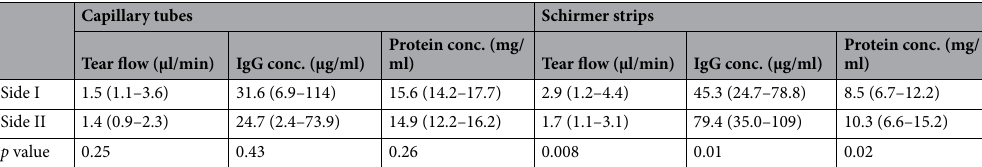
Table 2. Flow rate, total protein and IgG concentration. Tear fluid samples were collected with capillary tubes and Schirmer strips first from one eye (side I) followed by the other eye (side II). Results were compared to investigate a potential influence of the collection sequence. Values are displayed as median and interquartile range (IQR). n = 15 for tear flow, n = 10 for IgG and protein concentration. p values were calculated using the two-tailed Wilcoxon matched-pairs signed rank test, significant for p <